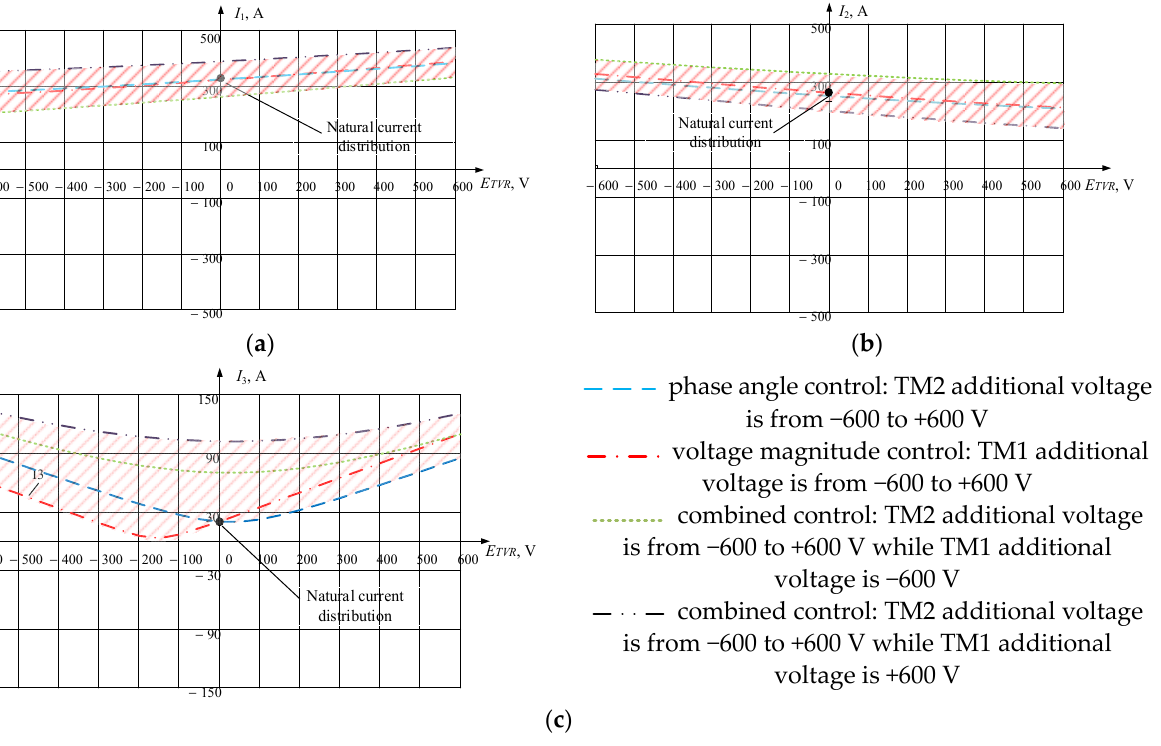
Figure 13. Change in currents I 1 and I 2 under combined control mode and constant load.